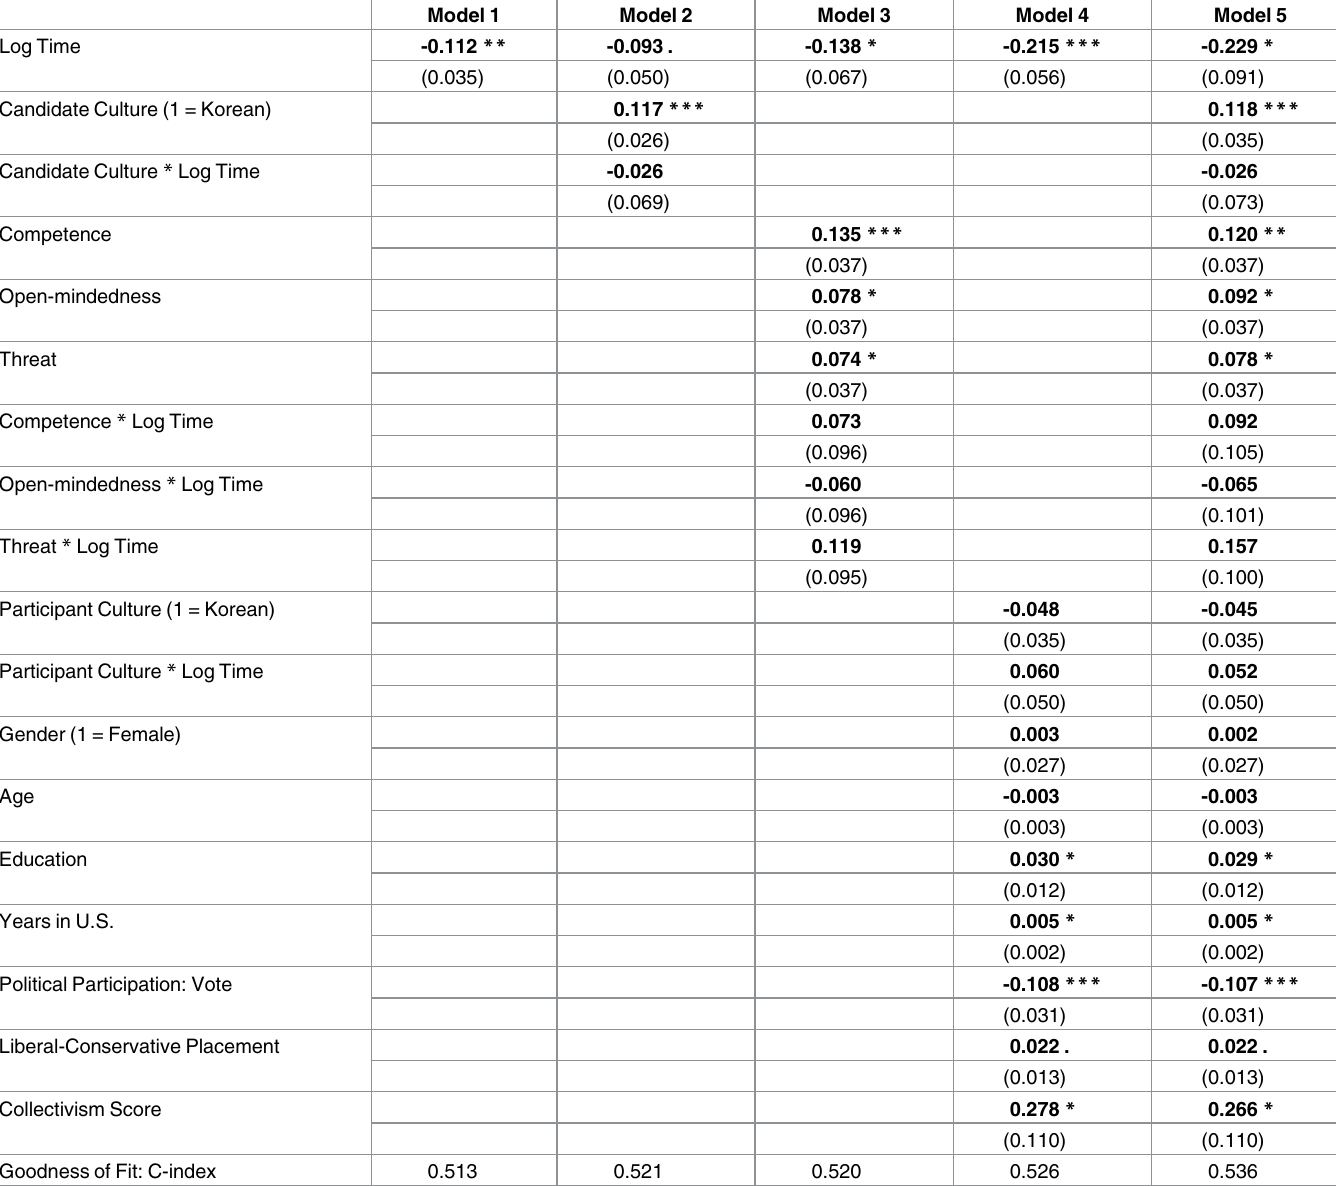
Table 6. The effect of response time on the association between face-basedtrait inferences and real election